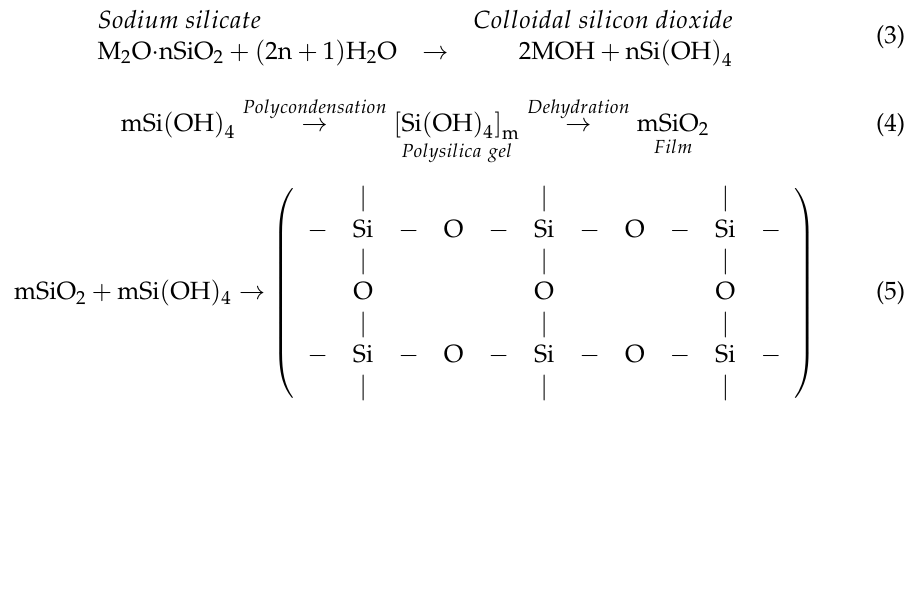
Figure 6. The water absorption of the coral aggregate that was treated with the SS solution.